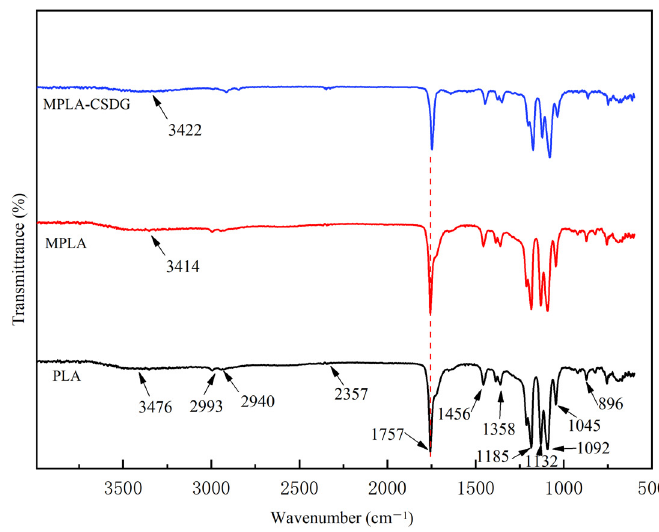
Figure 1. Fourier transform infrared spectra of PLA, MPLA, and MPLA/CSDG.